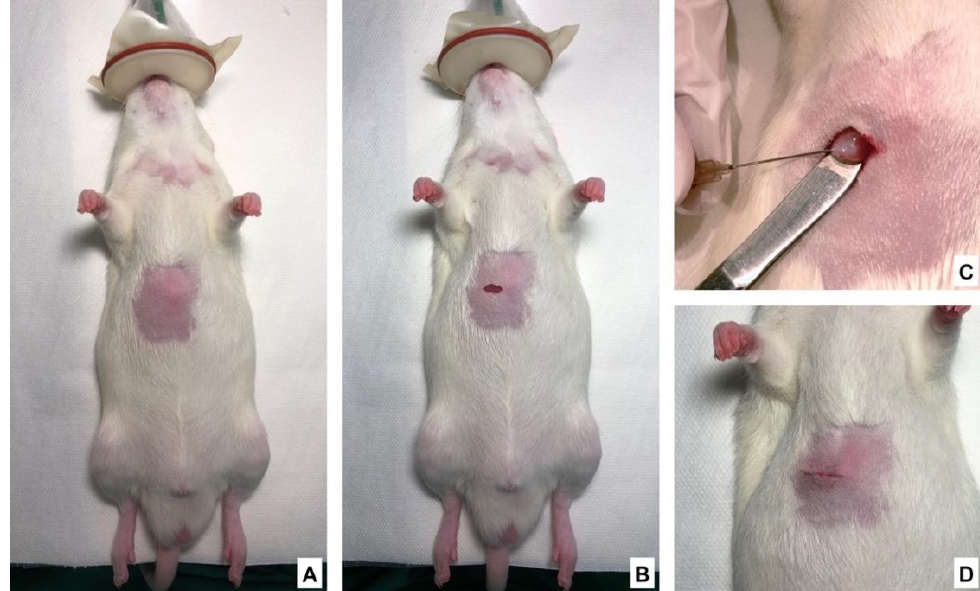
Figure 2. Induction of colorectal cancer liver metastasis: surgical procedure. ( A ) Tumor implantation was performed under general anesthesia; ( B ) Small subcostal incision on the right side of the abdomen; ( C ) Injection of tumor cells under the liver capsule (whitish protrusion in the injection site was the sign for successful inoculation); ( D ) Closed incision.